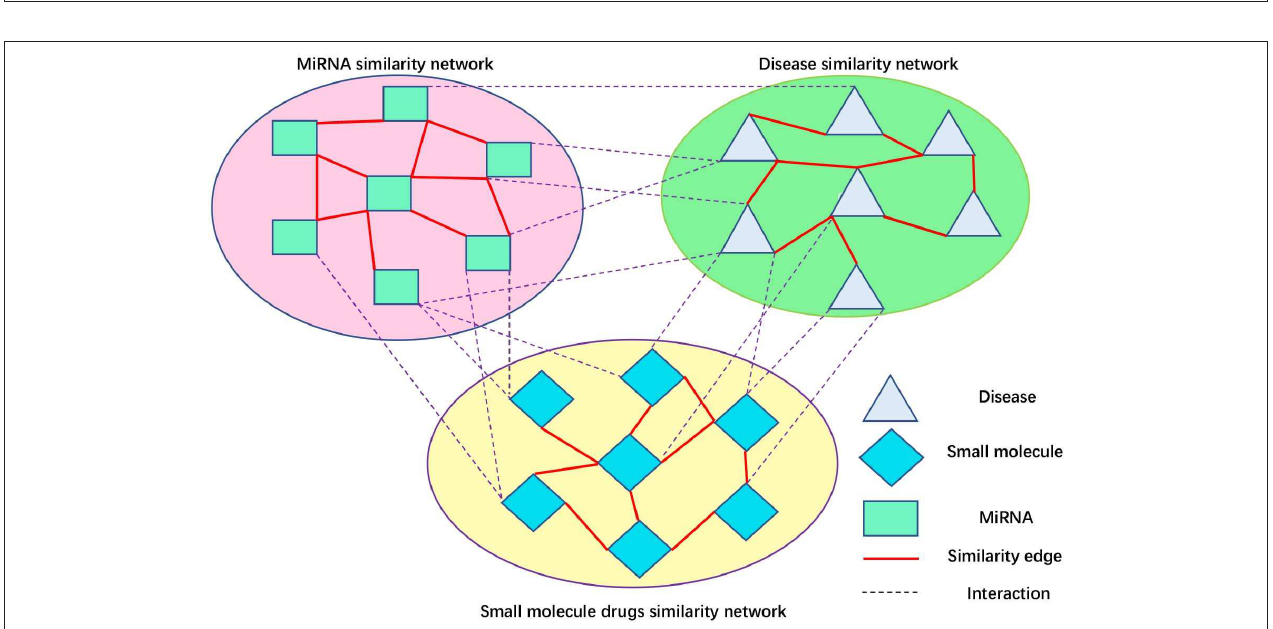
FIGURE 2 | The flowchart of extracting credible negative SMiR samples.